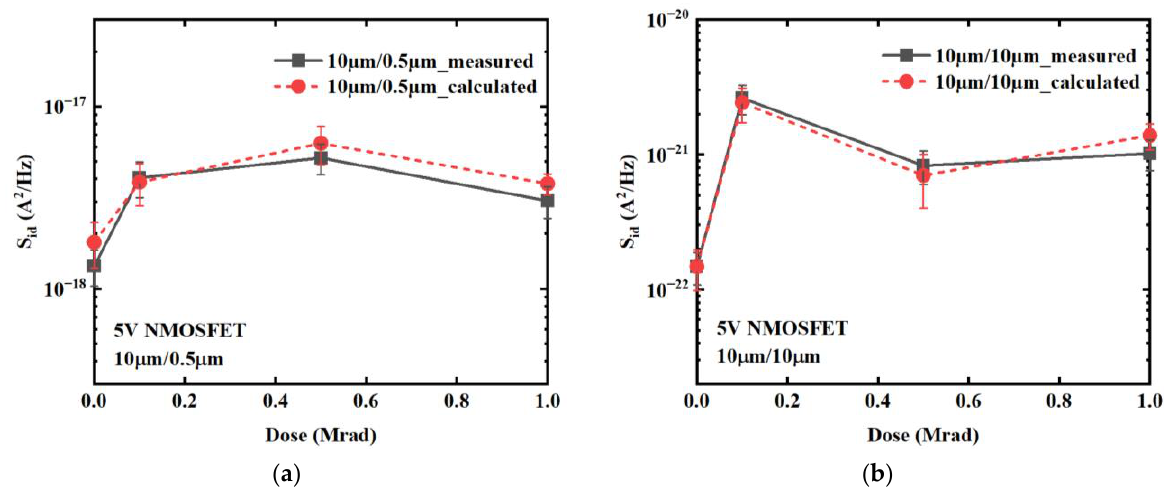
Figure 10. Noise magnitudes at f = 10Hz of 5V NMOSFETs for geometries: ( a ) W / L = 10 μm/0.5 μm and ( b ) 10 μm/10 μm as a function of irradiation dose which are measured and calculated under the modified physical mechanism.